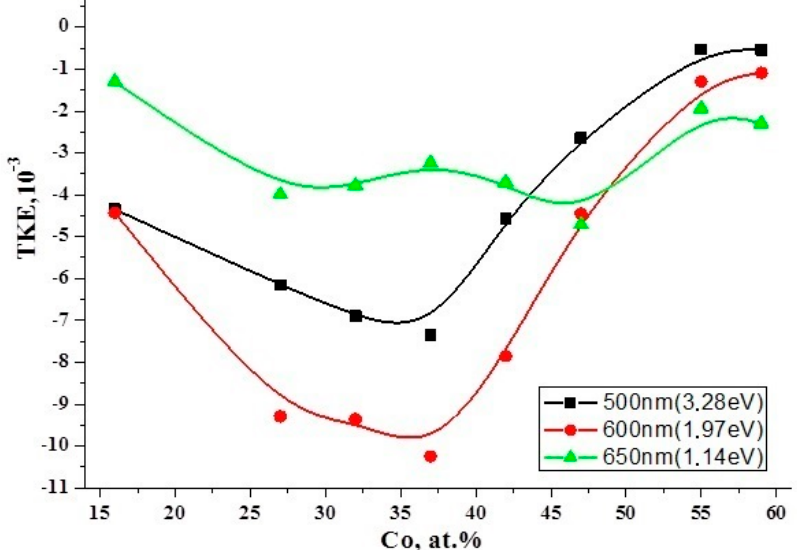
Figure 4. Concentration dependencies of the transversal Kerr effect (TKE) for nanocomposites Co x (MgF 2 ) 100-x at different values of incident light energy. Co x (MgF 2 ) 100-x at different values of incident light